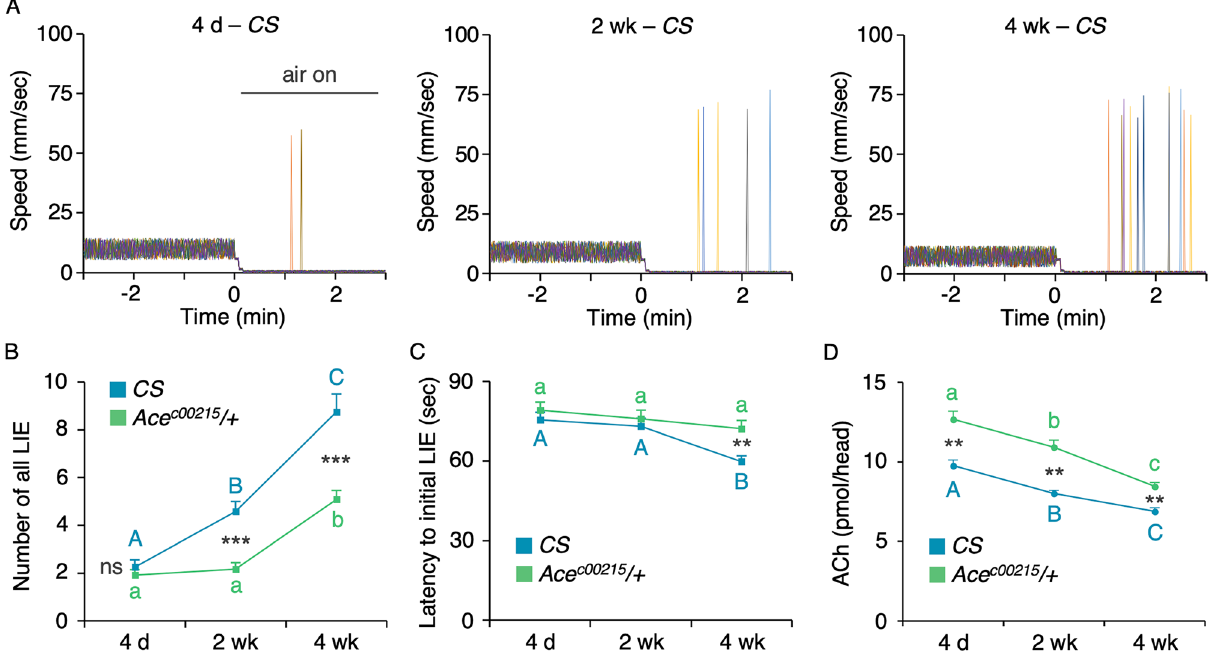
Figure 1. Aging diminishes inhibitory control in flies. ( A ) Representative movement traces of a group of 13 CS flies subjected to the GNG test in three chambers—one with the 4 day old, the other with the 2 week old and the last with the 4 week old. Each panel illustrates individual fly traces, which are denoted by the different colored lines. The timepoint when strong airflow was introduced is marked as 0 in the X axis. The CS flies of all three ages exhibited robust inhibitory control under airflow with infrequent instances of flying behavior representing LIE (movement > 60 mm/s). The sporadic LIEs increased with aging. ( B ) Quantitative representation of the aging-dependent increases in LIE and rescue by Ace deficiency . All LIEs displayed by 13 flies in a chamber for the entire 10 min under airflow during GNG test were manually counted revealing more frequent LIE in older CS flies (blue line). The aging-dependent increases in the LIE were alleviated by the heterozygous acetylcholinesterase ( Ace ) mutation (green line; Ace c00215 / +) fully at the 2 week old and partly at the 4 week old. ANOVA with post hoc Tukey multiple comparison of three ages in each genotype: different letters (A, B and C for CS ; a and b for Ace c00215 / +) denote statistically significant differences ( p < 0.05; n = 12). Student t -test between two genotypes ( Ace c00215 / + and CS ) in each age: ns, p > 0.05; ***, p < 0.0001; n = 12. ( C ) Latency to initial LIE. ANOVA with post hoc Tukey multiple comparison of three ages in each genotype: different letters (A and B for CS ) denote statistically significant differences ( p < 0.0001; n = 12). When the age-matching CS and Ace c00215 / + were compared by Student t -test, there is no difference in the LIE latency at 4 day or 2 week ( p > 0.05, n = 12; not noted in the graph) but there is significant difference at 4 week (**, p < 0.005, n = 12). The heterozygous Ace mutation fully reversed the aging-related premature LIE latency. ( D ) Acetylcholine levels in the CS and Ace c00215 / + heads. The acetylcholine levels were significantly higher in Ace c00215 / + than CS at all ages and dampened with aging in both genotypes. ANOVA with post hoc Tukey multiple comparison of three ages in each genotype: different letters (A, B and C for CS ; a, b and c for Ace c00215 / +) denote statistically significant differences ( p < 0.05; n = 4). Student t -test between two genotypes ( Ace c00215 / + and CS ) in each age: **, p < 0.005; n =